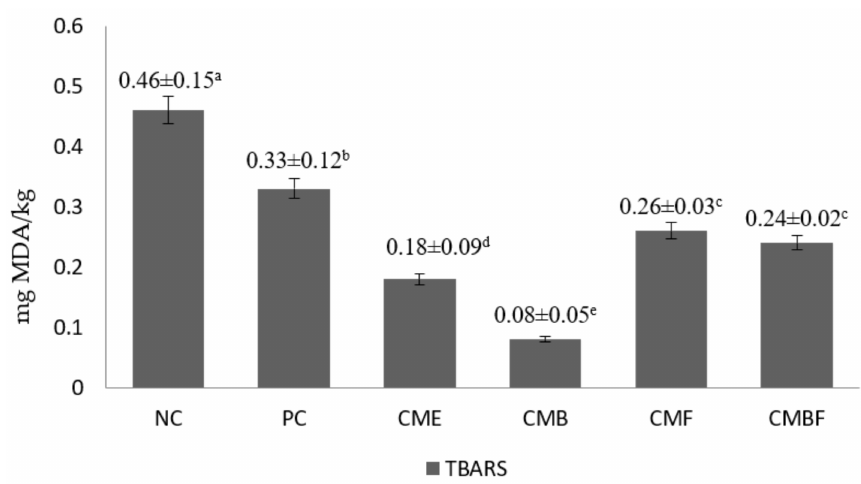
Figure 1. The lipid oxidation rate of the breast meat of Korean ginseng chicken soup that was hydrolyzed with Cordyceps militaris mushroom extract. NC, negative control; PC, Positive control, Samgyetang that was hydrolyzed with flavorzyme before retorting; CME, Samgyetang that was made with the addition of Cordyceps militaris mushroom extract; CMB, Samgyetang that was hy- drolyzed with Cordyceps militaris mushroom extract: bromelain before retorting; CMF, Samgyetang that was hydrolyzed with Cordyceps militaris mushroom extract: flavorzyme before retorting; CMBF, Samgyetang that was hydrolyzed with Cordyceps militaris mushroom extract: bromelain:flavorzyme before retorting. The values with different superscripts were significantly different ( p < 0.05).